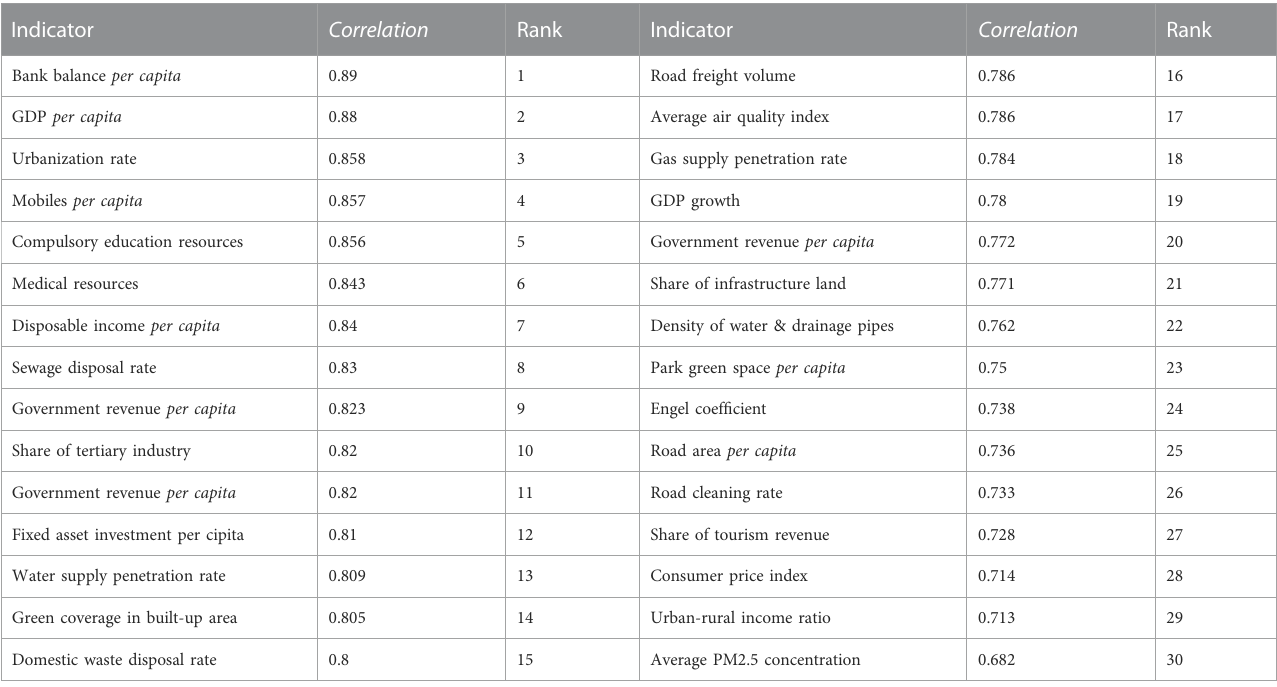
TABLE 3 Grey correlation of each